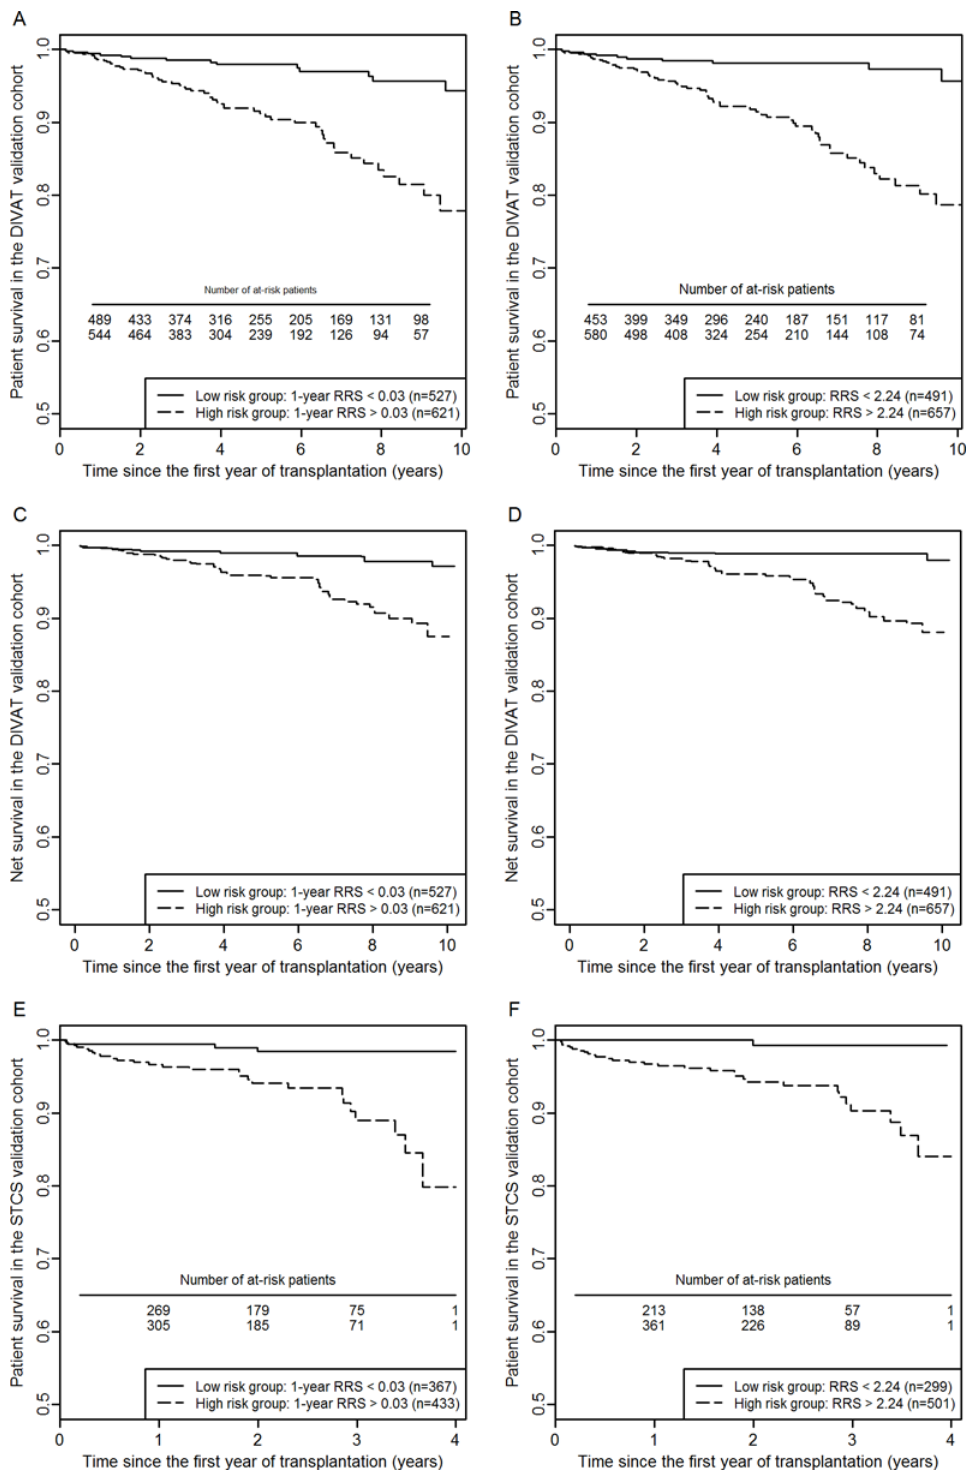
Fig 3. Patient survival curves according to the two groups defined by the 1-year RRS threshold at 0.03 (A, C, E) or the RRS threshold at 2.24 (B, D, F). (A, B) The analyses concerned the all-cause mortality in the DIVAT validation sample (n = 1148). (A) The black continuous line corresponds to the low-risk group with a 95.1% probability of being still alive with a functioning graft at 10 years since the first anniversary of the